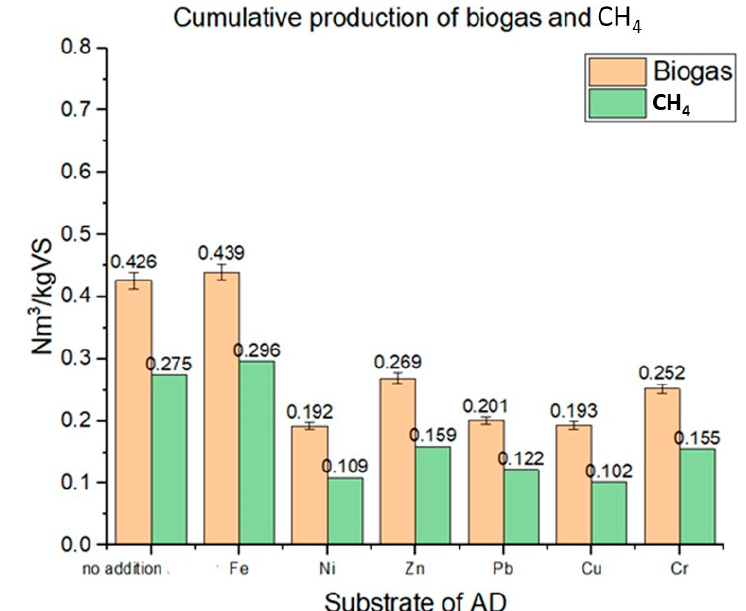
Figure 5. ( a )—Impact of Cu on the performance of AD; ( b )—Impact of Cr on the performance of AD.